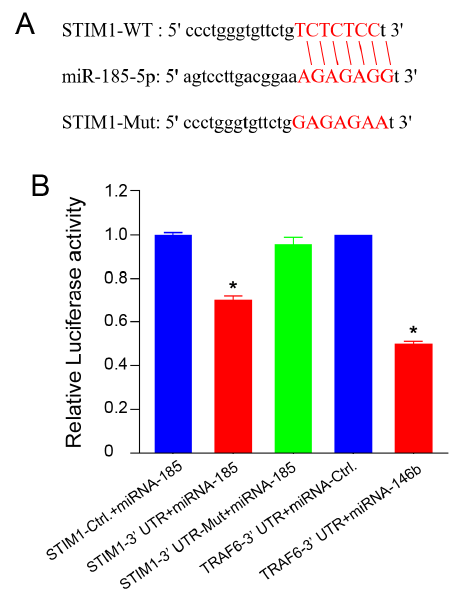
reduction in the STIM1 expression in miRNA-185-5p-overexpressing cells (Figure 5G). Thus, miRNA-185-5p targets and negatively regulates the STIM1 expression in invasive 5–8F cells.